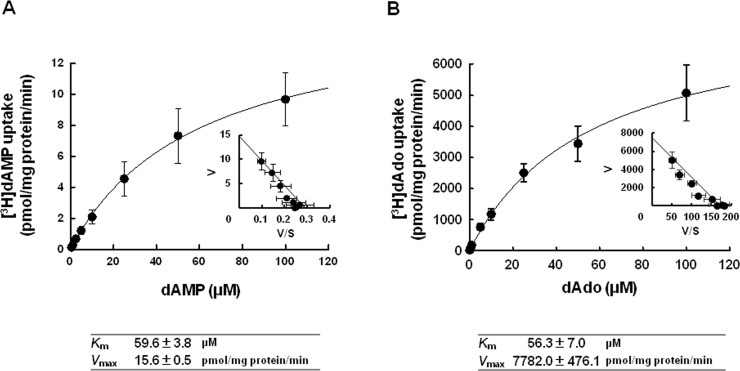
Saturation kinetics of CNT3-mediated uptake of [3H]dAMP and [3H]dAdo.(A) The uptake of [3H]dAMP was estimated over a concentration range of 0.1–100 μM at pH 7.4 for 30 min. (B) The uptake of [3H]dAdo was estimated over a concentration range of 0.1–100 μM at pH 7.4 for 30 sec. The specific uptake by CNT3 was estimated by subtracting its uptake by mock cells from that by COS-7 cells transiently expressing CNT3. Inset: Eadie-Hofstee plot. Each point represents the mean ± S.E. of 3 independent experiments performed in triplicate.